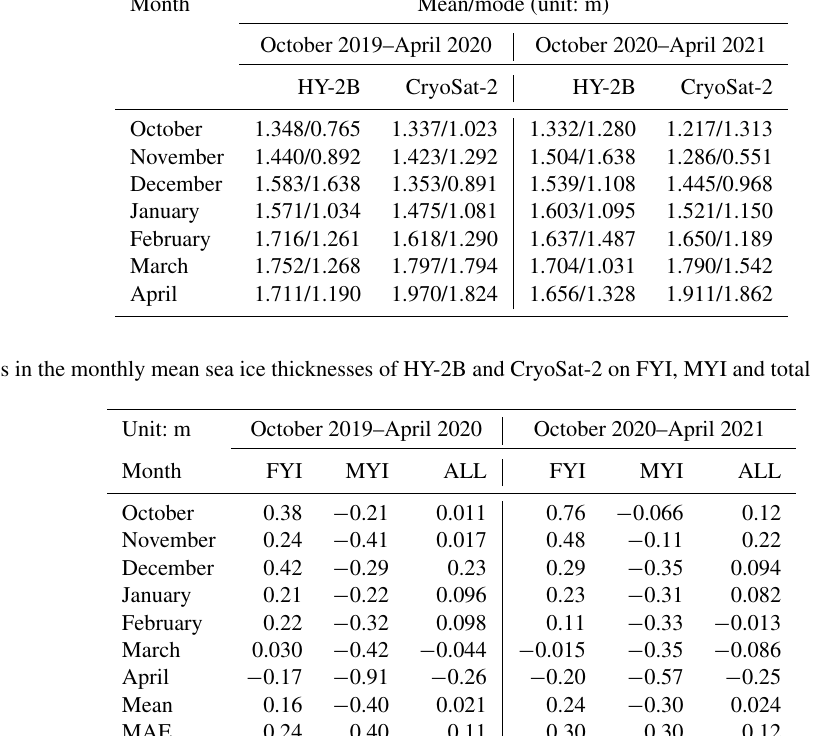
Table 5. Mean and modal sea ice thickness values of HY-2B and CryoSat-2 in the common area. Month